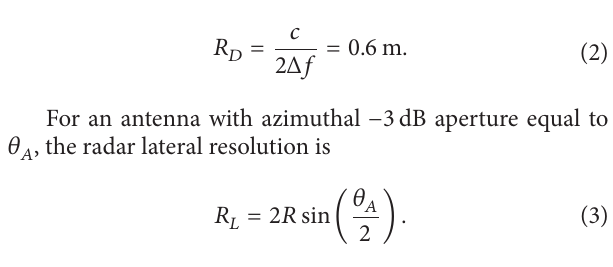
From the FMCW radar theory [10], the range